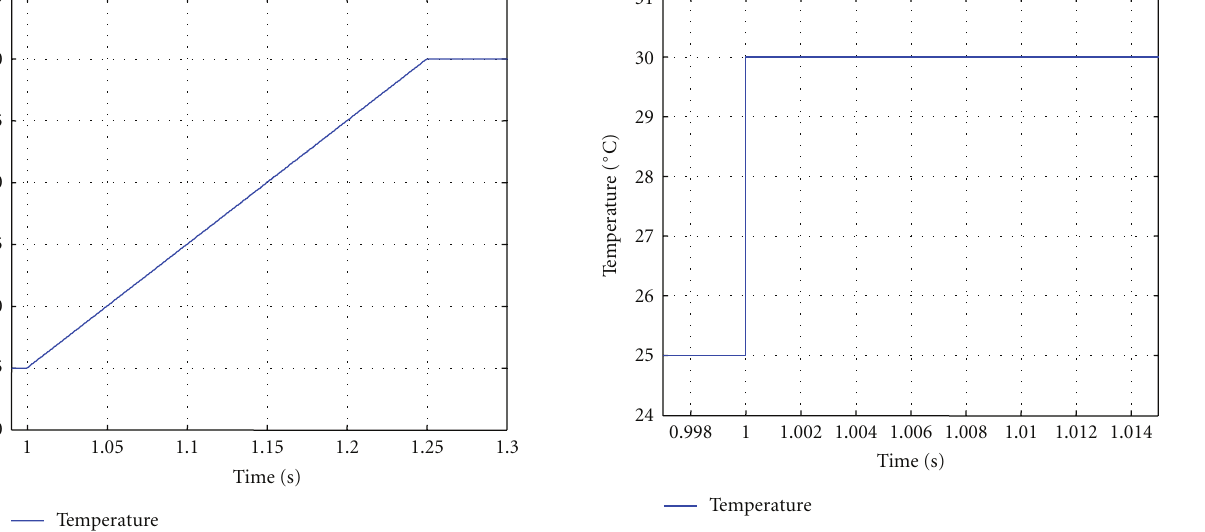
Figure 20: Drastic temperature changes from 25 ◦ C to 30 ◦ C.